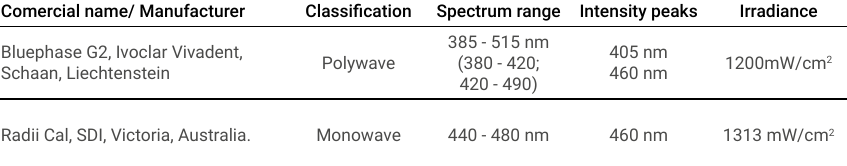
Table 2. Technical details of light emitting diodes used in this study according to the manufacturers. Comercial name/